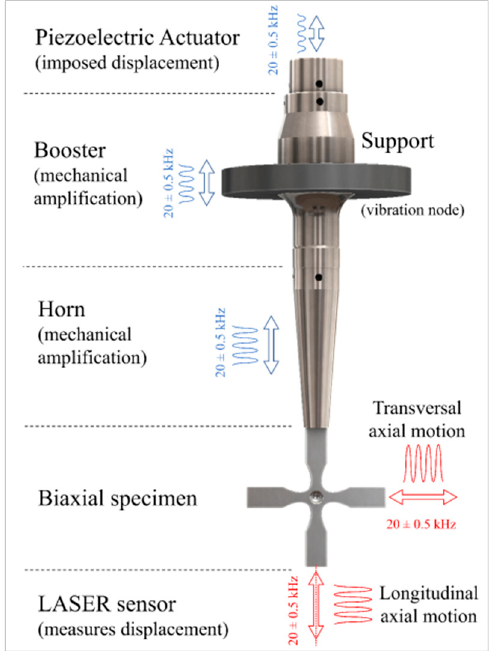
Figure 16. VHCF testing machine resonant system components with UFT biaxial specimen [25].